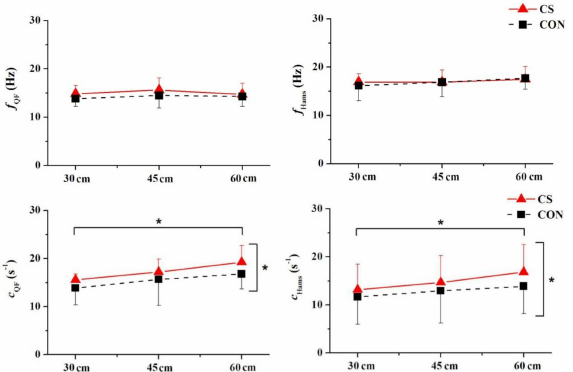
Figure 6. Compression effects on the vibration frequency ( f ) and damping coefficient ( c ) of quadriceps femoris (QF) and hamstrings (Hams) during landings. Upper-pointing brackets (*) indicate a signifi- cant difference between 30 cm landing height and 60 cm landing height ( p < 0.05). Right-pointing brackets (*) indicate a significant difference at 60 cm landing height ( p <